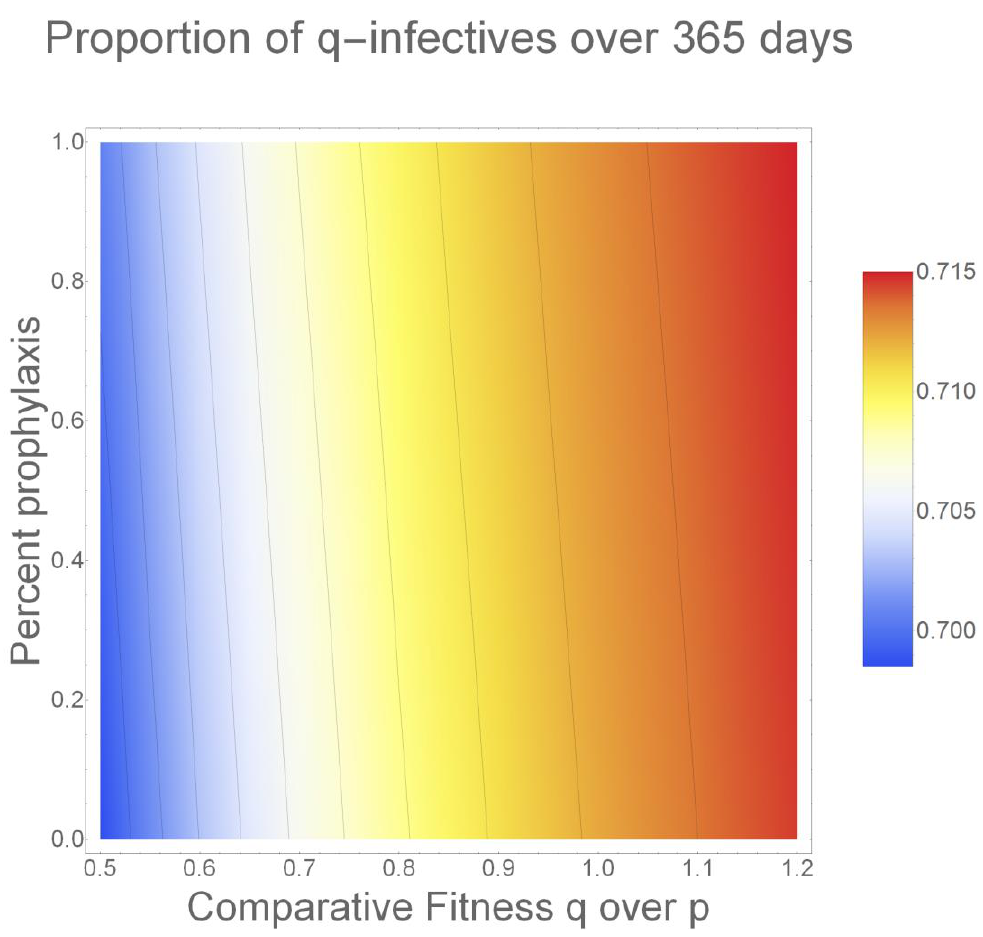
Figure 4. Combined Impact of Comparative Fitness and Percent Prophylaxis Use: Here, we present a heat map representing the change in q-strain prevalence that occurs due to prophylaxis use and changes in comparative fitness. We demonstrate that increased prophylaxis use, and increased comparative fitness, both benefit the resistant strain. While the magnitude of the effect of increased relative fitness is observably greater, even when the relative fitness of q is low, the selective pressure imposed by prophylaxis use increases q-strain prevalence overall (we note that the lines appearing on the heat map are present for visual assistance only).